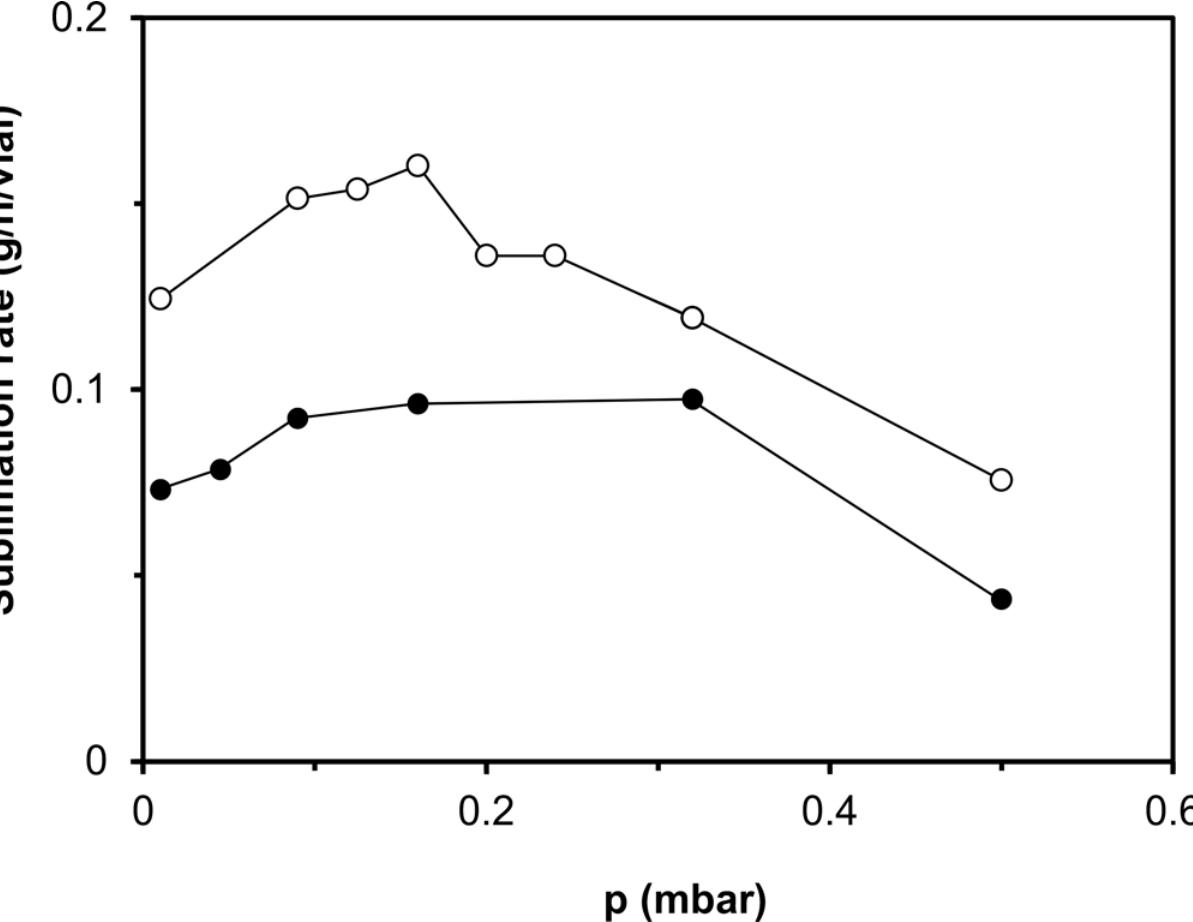
Fig 2. Effect of the chamber pressure on the average sublimation rate of HGT-medium (black circle), and purified water (clear circle) in the pilot freeze-dryer. The sublimation rate was calculated from the time course to sublimate 100 g of ice.